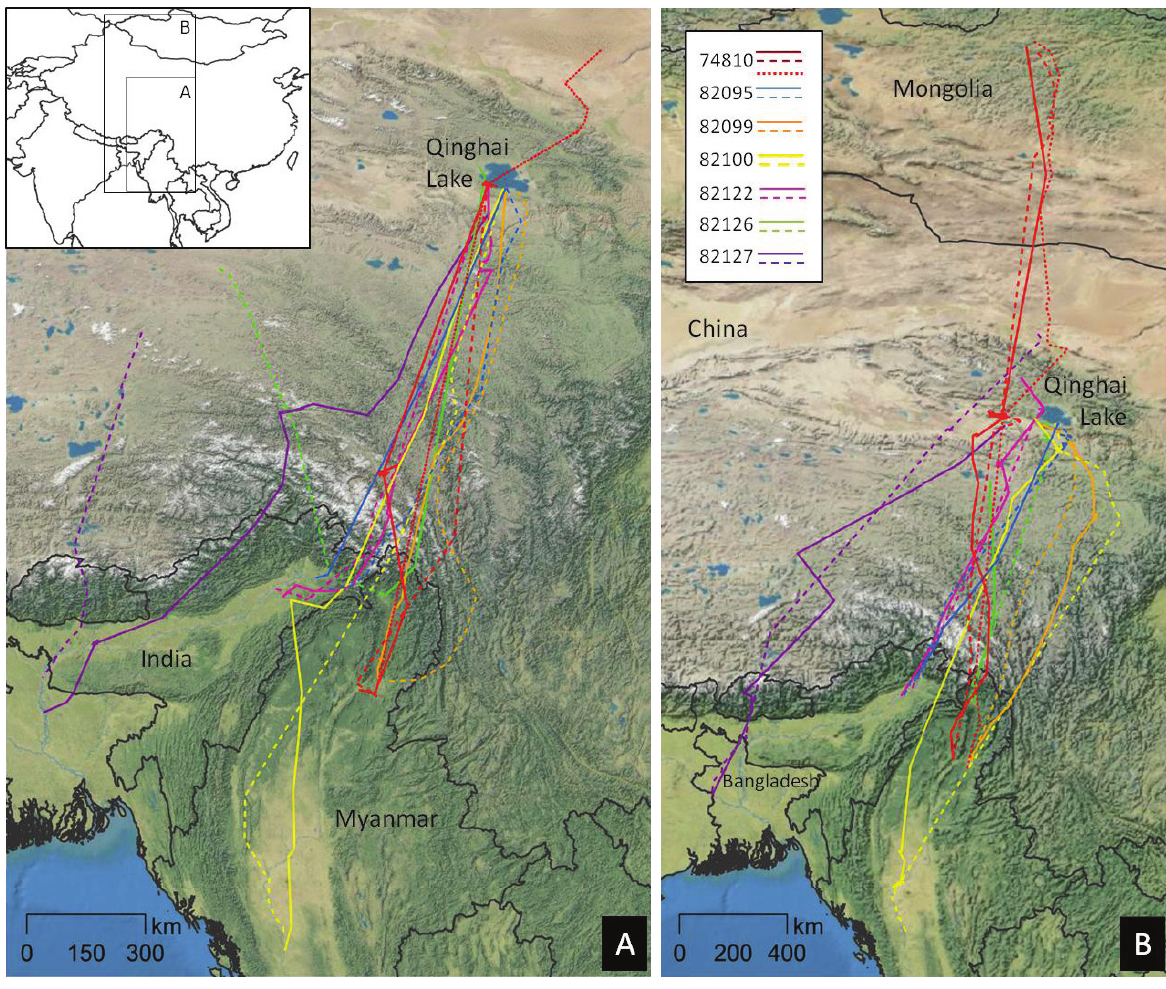
Figure 4. Routes for ruddy shelducks marked at Qinghai Lake, China and followed for at least two seasonal migratory cycles. Repeated migratory routes for seven ruddy shelducks marked at Qinghai Lake, 2007 – 2008. All seven shelducks completed two or more full migration movements (fall and spring). Paths are given for ( A ) fall (2007 – 2009) and ( B ) spring (2008 – 2010) migration movements, with solid, dashed, and dotted lines as first, second, and third journeys,